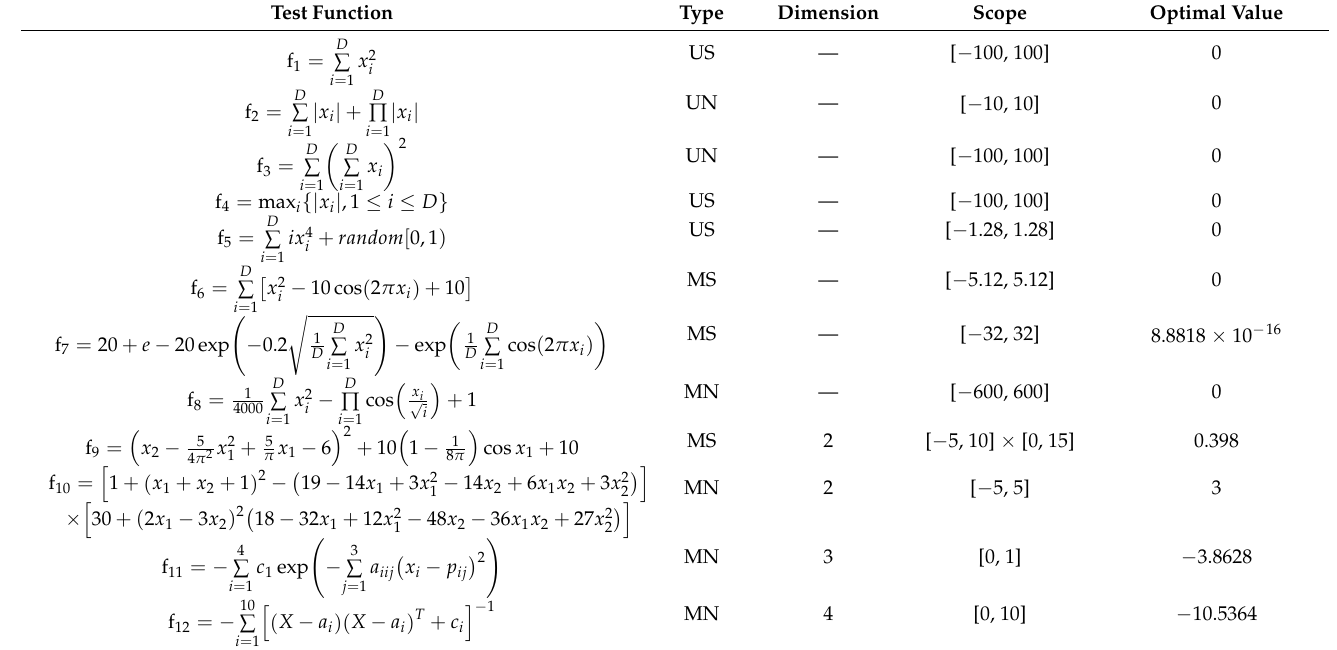
Table 1. Test functions specific information.